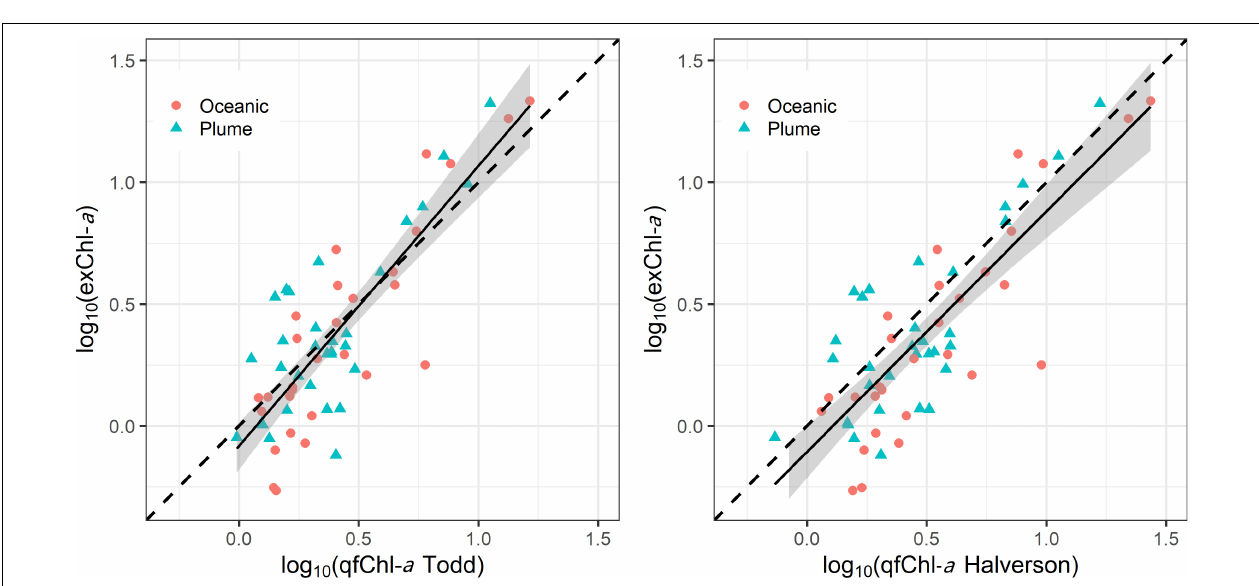
FIGURE 7 | Regression between log10 transformed qfChl- a Todd and HPLC (left) and qfChl- a Halverson (right). The red circles are sampled from the plume and the blue triangles are sampled in oceanic waters. Note that data were log 10 transformed to account for the non-normal distribution of Chl- a (Seegers et al.,